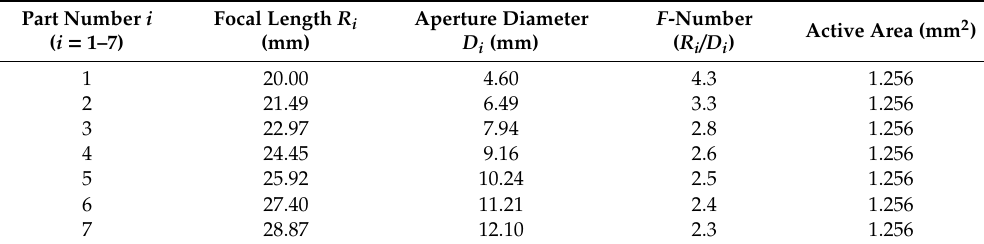
Table 2. Parameters of the MFP transducer.